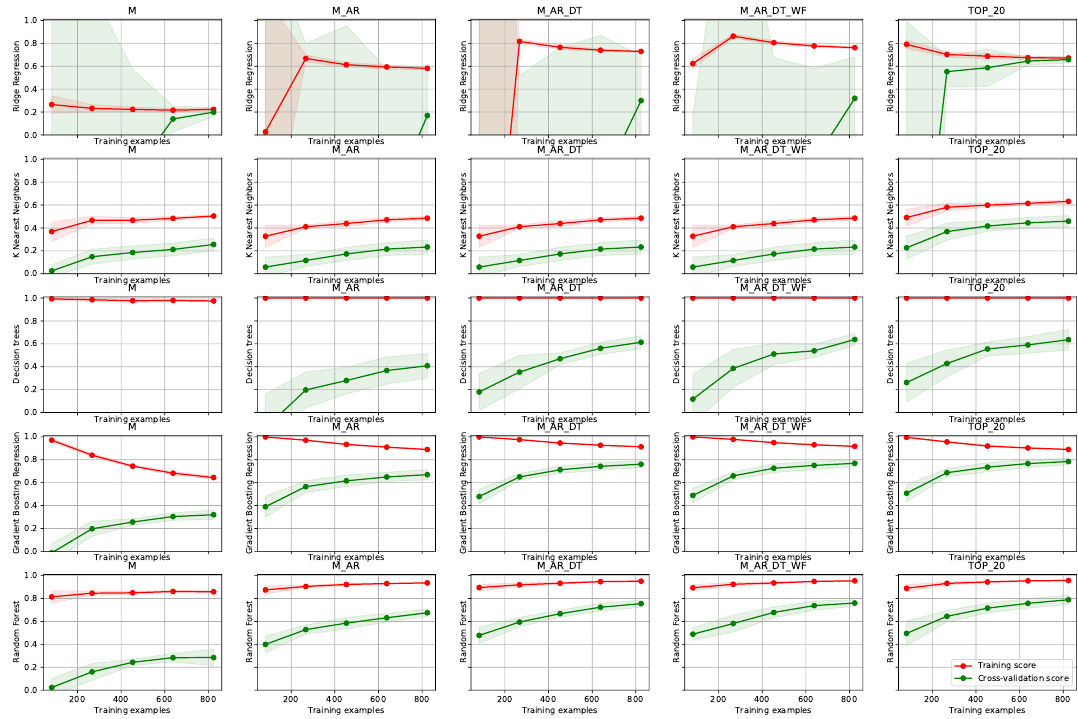
Figure 7. Learning curves on the train substation feeder use case. The structure of the figure mirrors the one from Figure